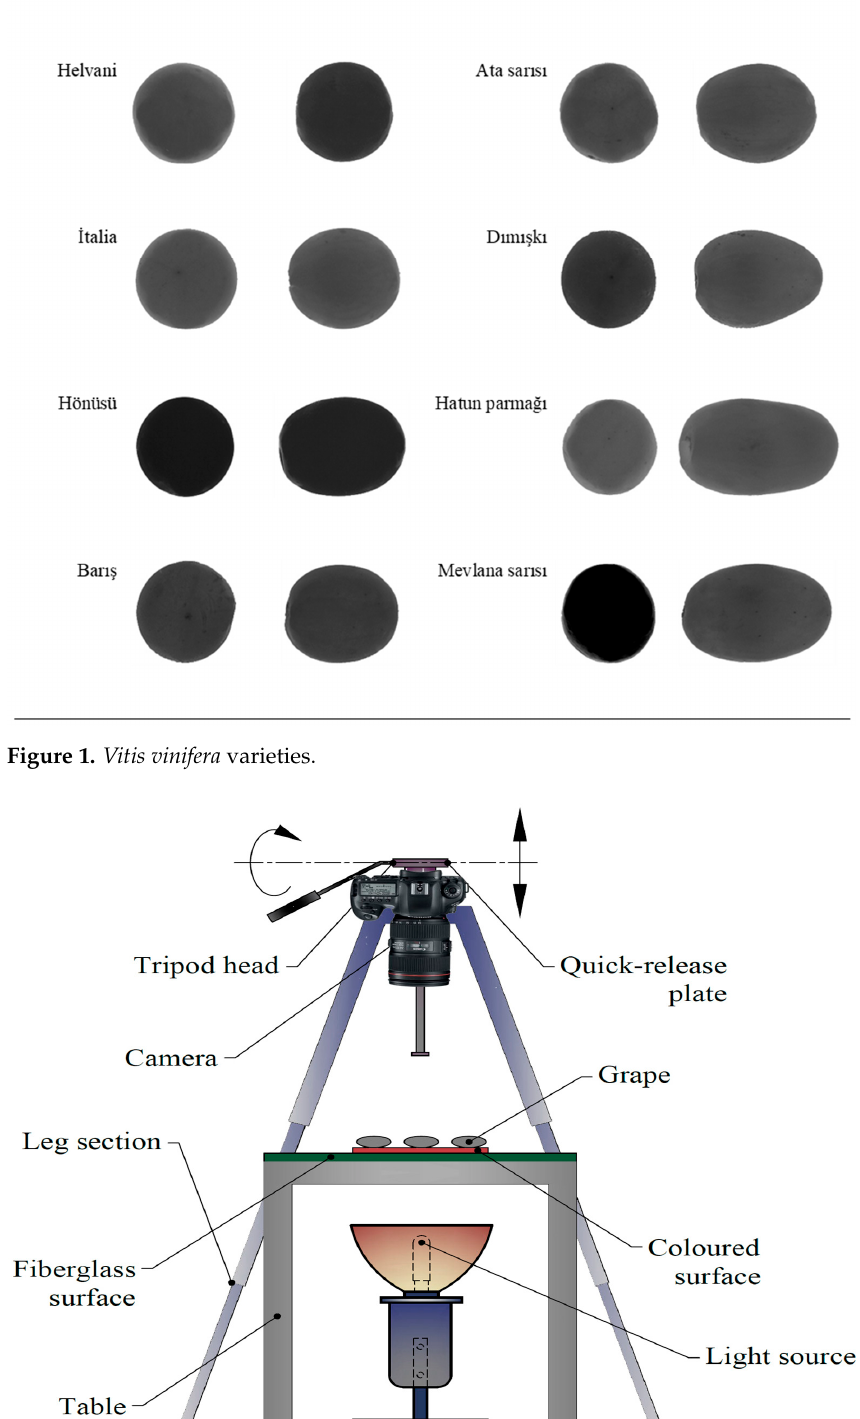
Figure 2. Image acquisition system.